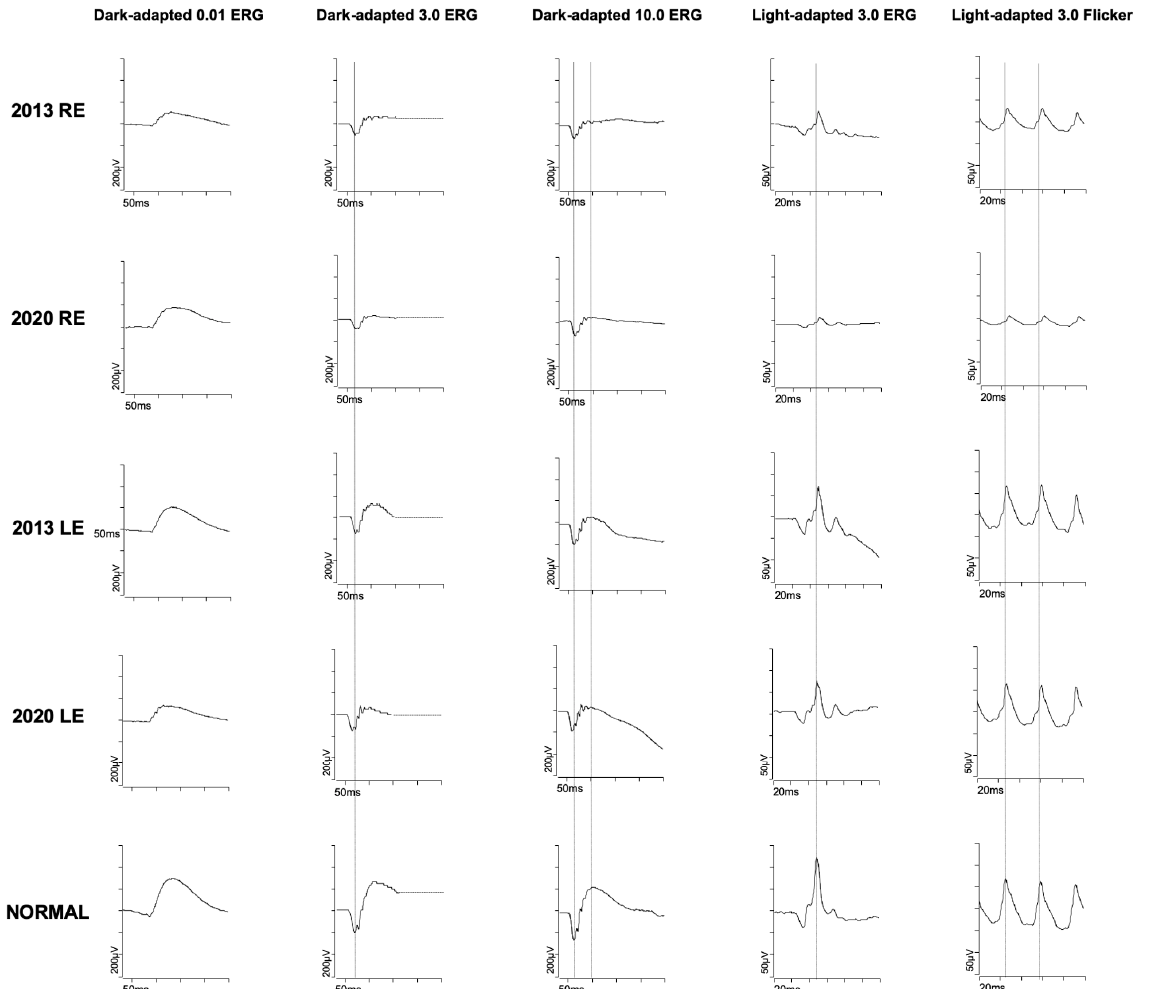
Figure 2. Full-field Electroretinogram (ERG), left and right eye at presentation and after seven years displaying decreased amplitudes of the photopic responses of the right eye that worsened with follow-up. Scotopic responses were within normal limits.